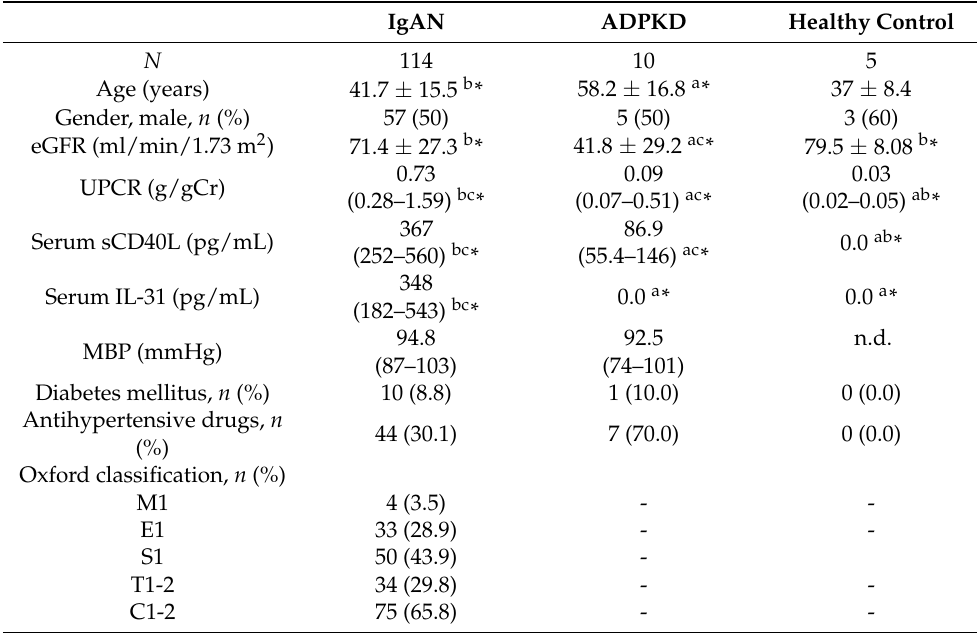
Table 1. Baseline characteristics of the study